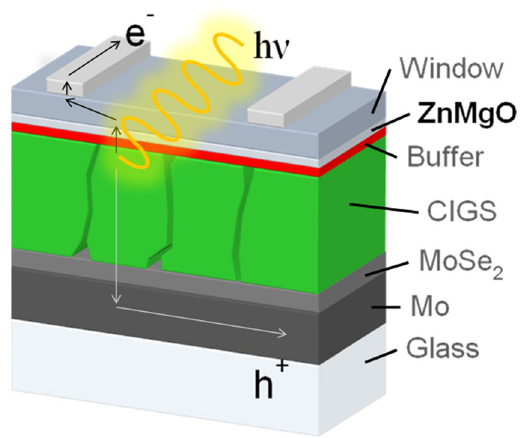
Figure 1. Schematic representation of a high efficiency Cd-free chalcogenide solar cell, including a back Mo contact deposited on the substrate (typically SLG), the CIGS absorber layer, a nanometric Zn(O,S) buffer layer, a ZnO based window layer and a nanometric ZnMgO interficial layer between the buffer and window ones. For high efficiency pure sulfide CIGS devices, the ZnMgO layer replaces the Zn(O,S) buffer